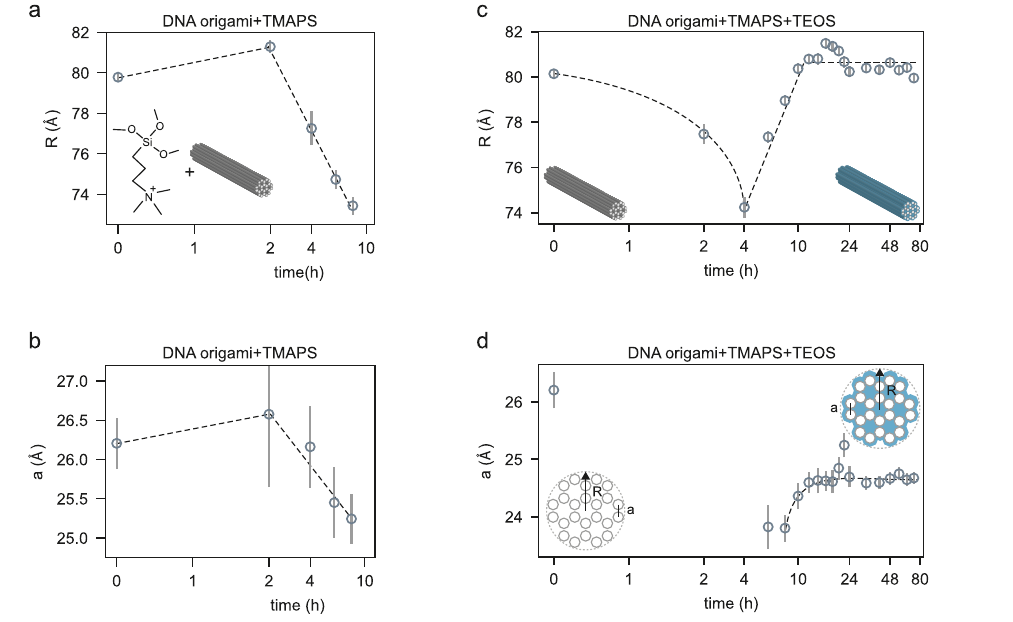
guidetotheeye.Schematicofthe24HBhoneycomblatticestructureareshownas insets. Error bars indicate standard deviation σ due to modelling of the x-ray data for each time